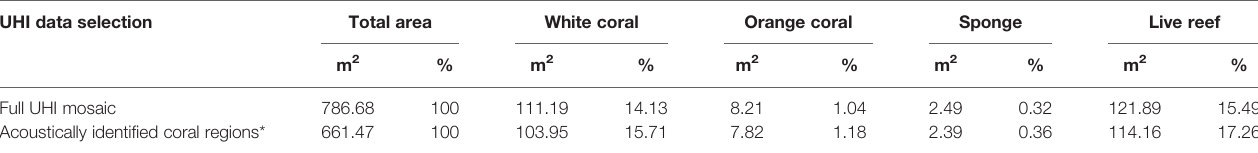
TABLE 4 | Results of the support-vector machine (SVM) classi fi cation of the underwater hyperspectral imaging (UHI) dataset from the Tautra Ridge. UHI data